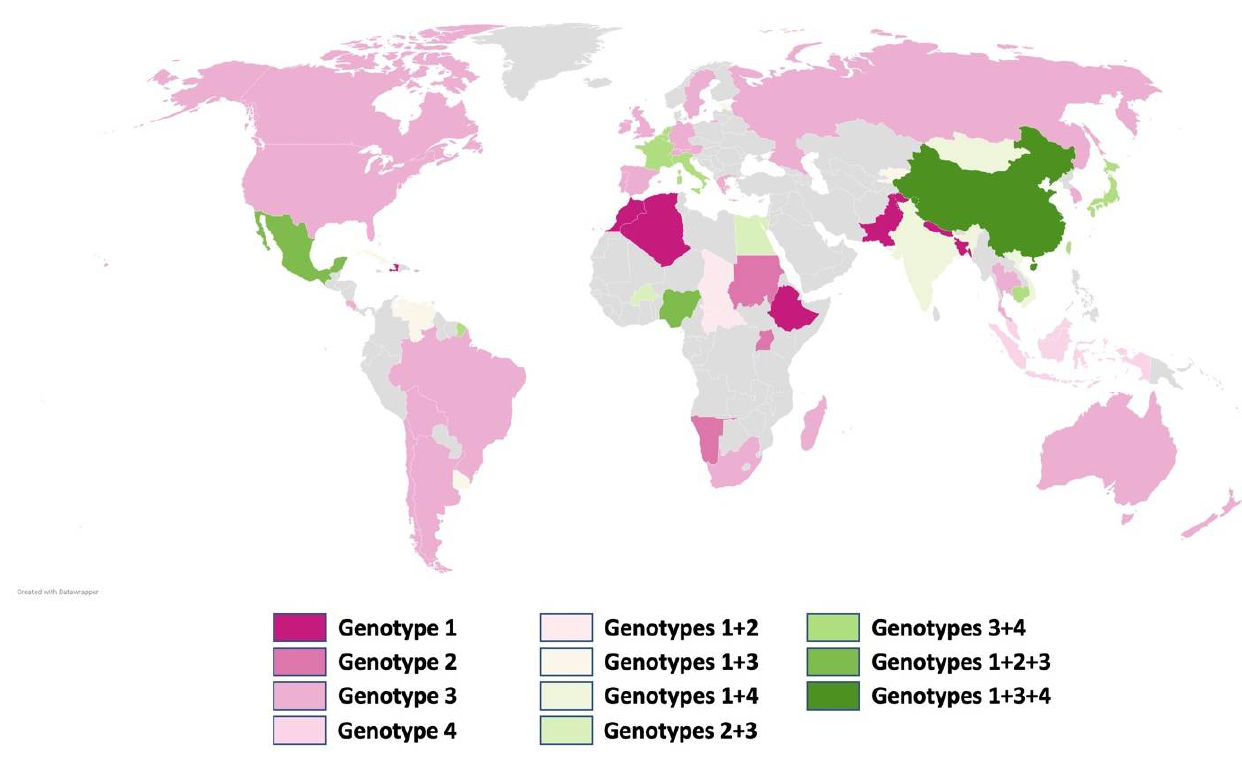
Figure 1. Map with the geographical distribution of the four major human pathogen HEV genotypes. Data adapted from WHO and map generated with Datawrapper, Berlin, Germany.